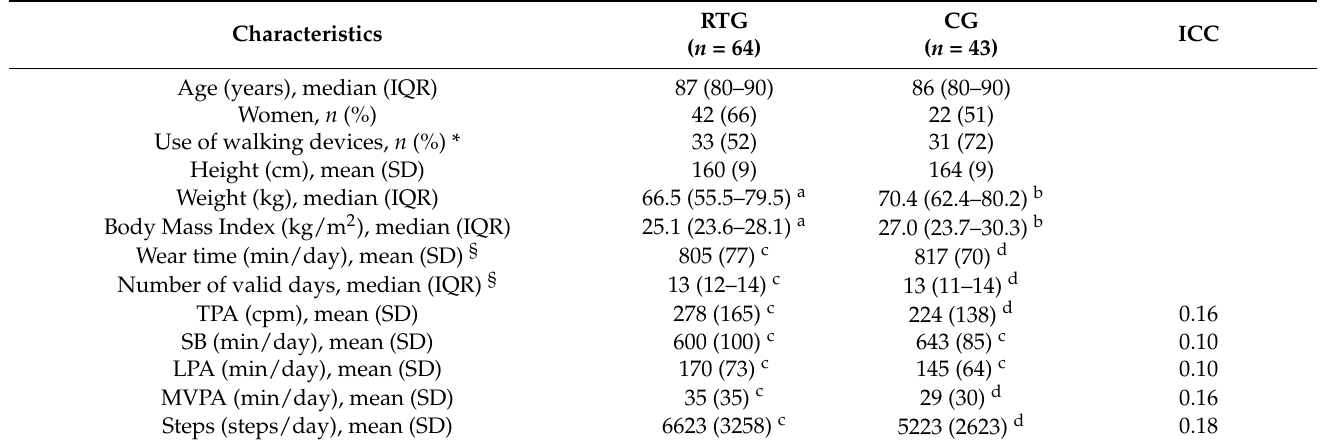
Table 1. Baseline characteristics of the